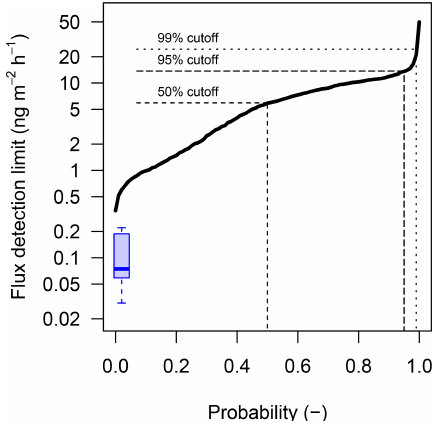
Figure 6. Flux detection limit empirical probability distribution of the magnitude of flux measurements under outdoor conditions (black line). The boxplot insert shows the range of the magnitude of measured fluxes during the zero-flux experiment in the labo- ratory without Hg 0 sources under very low-turbulence conditions. The black line shows the theoretical detection limit based on the sta- tistical significance ( p <0.05) of the correlation coefficient between the vertical wind speed and Hg 0